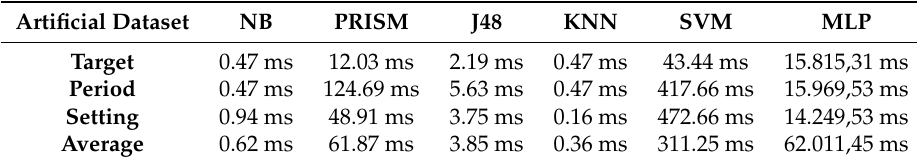
Table 7. CPU time test for training.